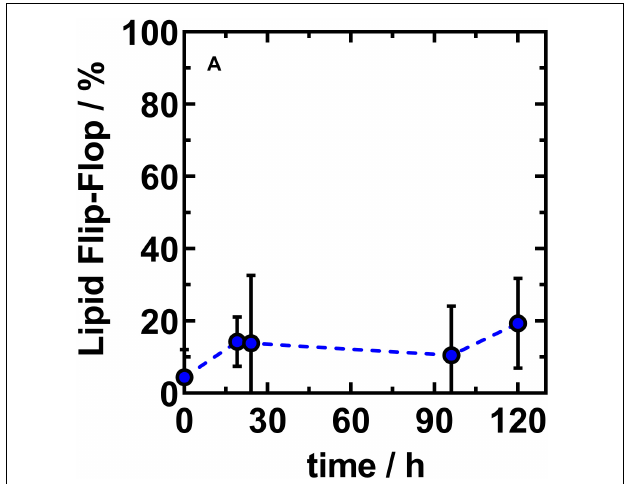
FIGURE 5 | The net lipid translocation into the outer leaflet of asymmetric LPS R45/PL vesicles largely finds a saturation level at a NBD-PE fraction of about 20%. Fraction of NBD-PE found in the outer leaflet of asymmetric vesicles reconstituted from LPS R45 (OL) and PE:PG:CL (IL; 81:17:2; w/w/w). The ability of lipid flip-flop of NBD-PE is monitored over time. Initial flip-flop from inner to outer leaflet occurs fast (1 h) after phase transfer and asymmetric vesicle generation. Asymmetric vesicles with stable outer leaflet composition are achieved approximately 19 h after final preparation. Data shown represent the mean value of three independent experiments ± SD ( n =